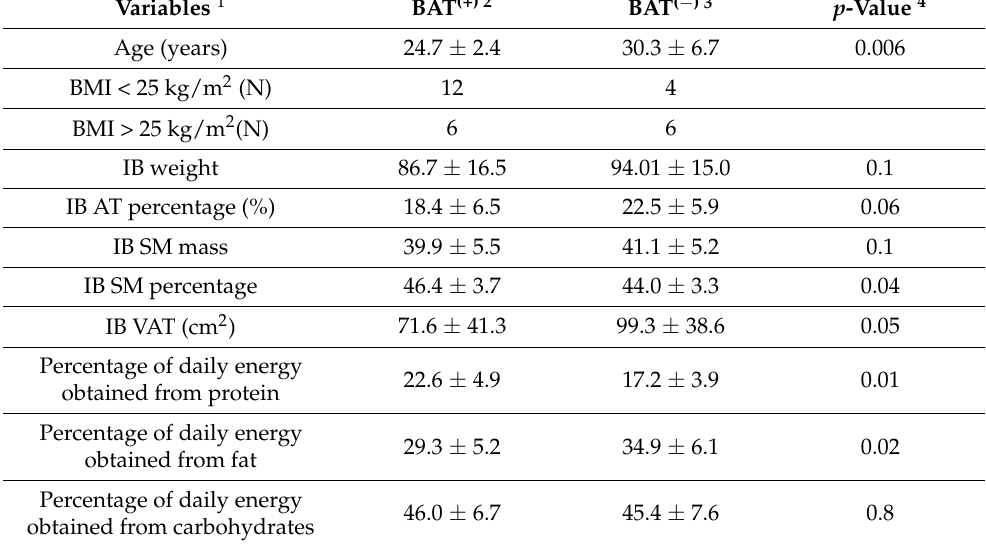
Table 1. Characteristics of BAT (+) and BAT ( − ) male